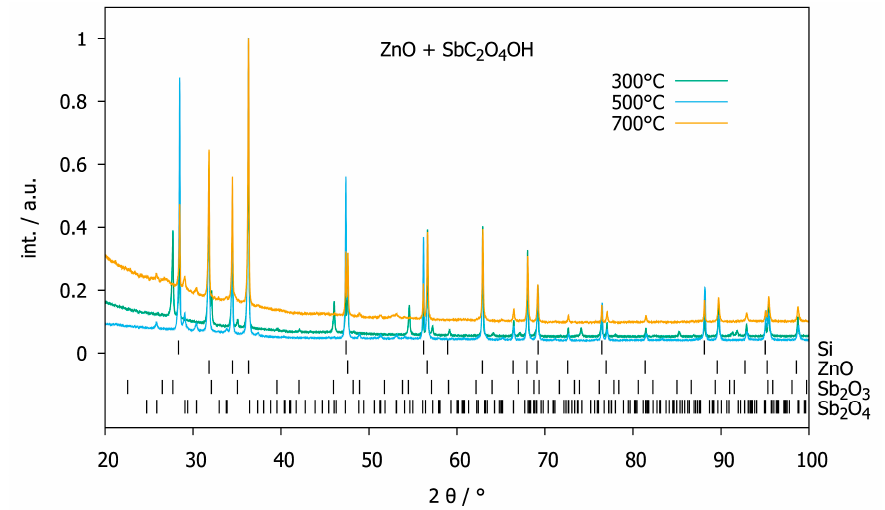
Figure 6. XRPD patterns (normalized intensities, Huber G670 di ff ractometer, CuK α 1 radiation, internal standard silicon powder) of a mixture of ZnO and SbC 2 O 4 OH with a 10:1 molar ratio after heat treatment at 573 K (green), 773 K (blue) and 973 K (orange),